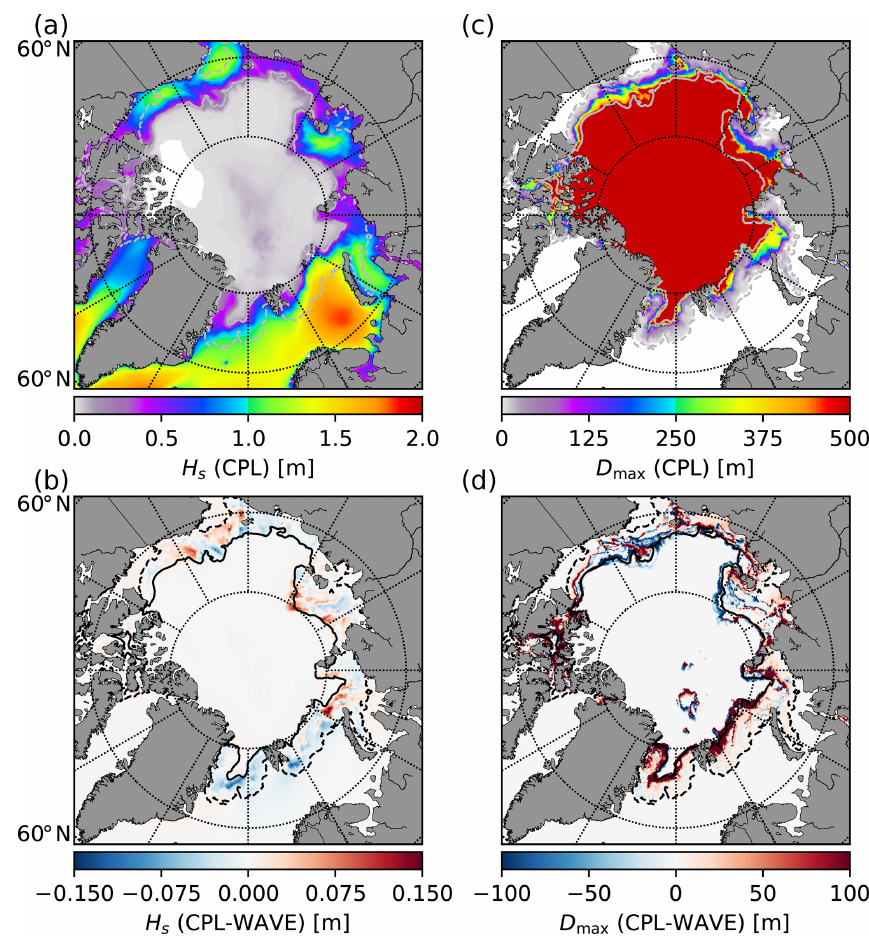
Figure 6. Significant wave height (a) and maximum floe size (c) in the CPL simulation averaged over the period 3 August to 9 September 2010 and the differences with the WAVE simulations (b, d) . The black and grey contours delimit the MIZ in the CPL simulation, defined here as 0 < (cid:104) D max (cid:105) < 700m. Note that the sea ice conditions from the NOT_CPL run are used as forcing for the WAVE run and are thus similar in the WAVE and the NOT_CPL